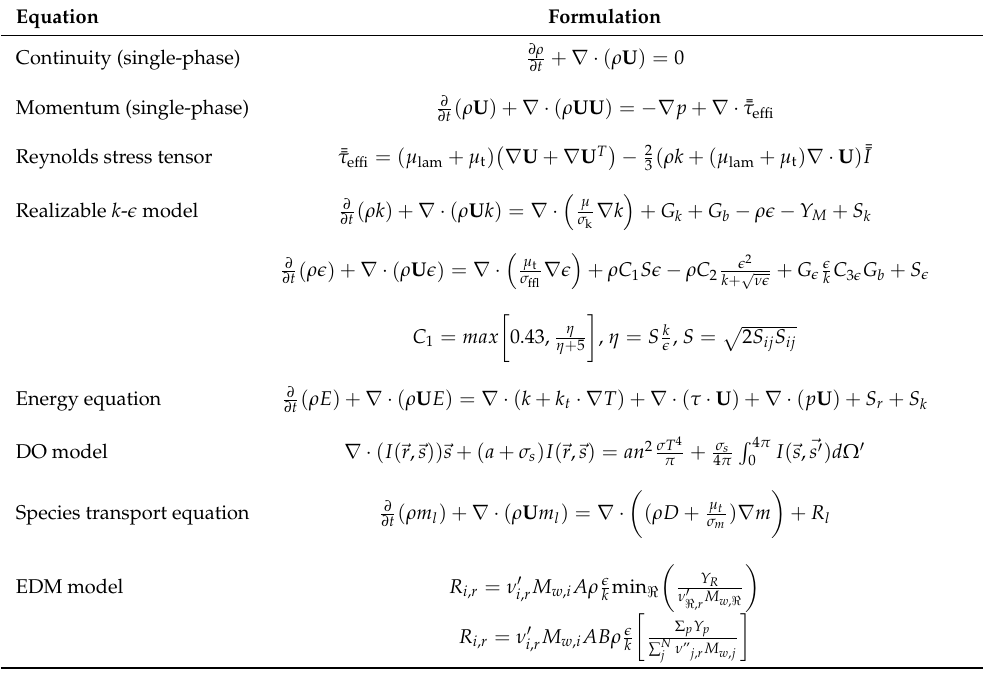
Table 5. Governing equations of Fireside [18].